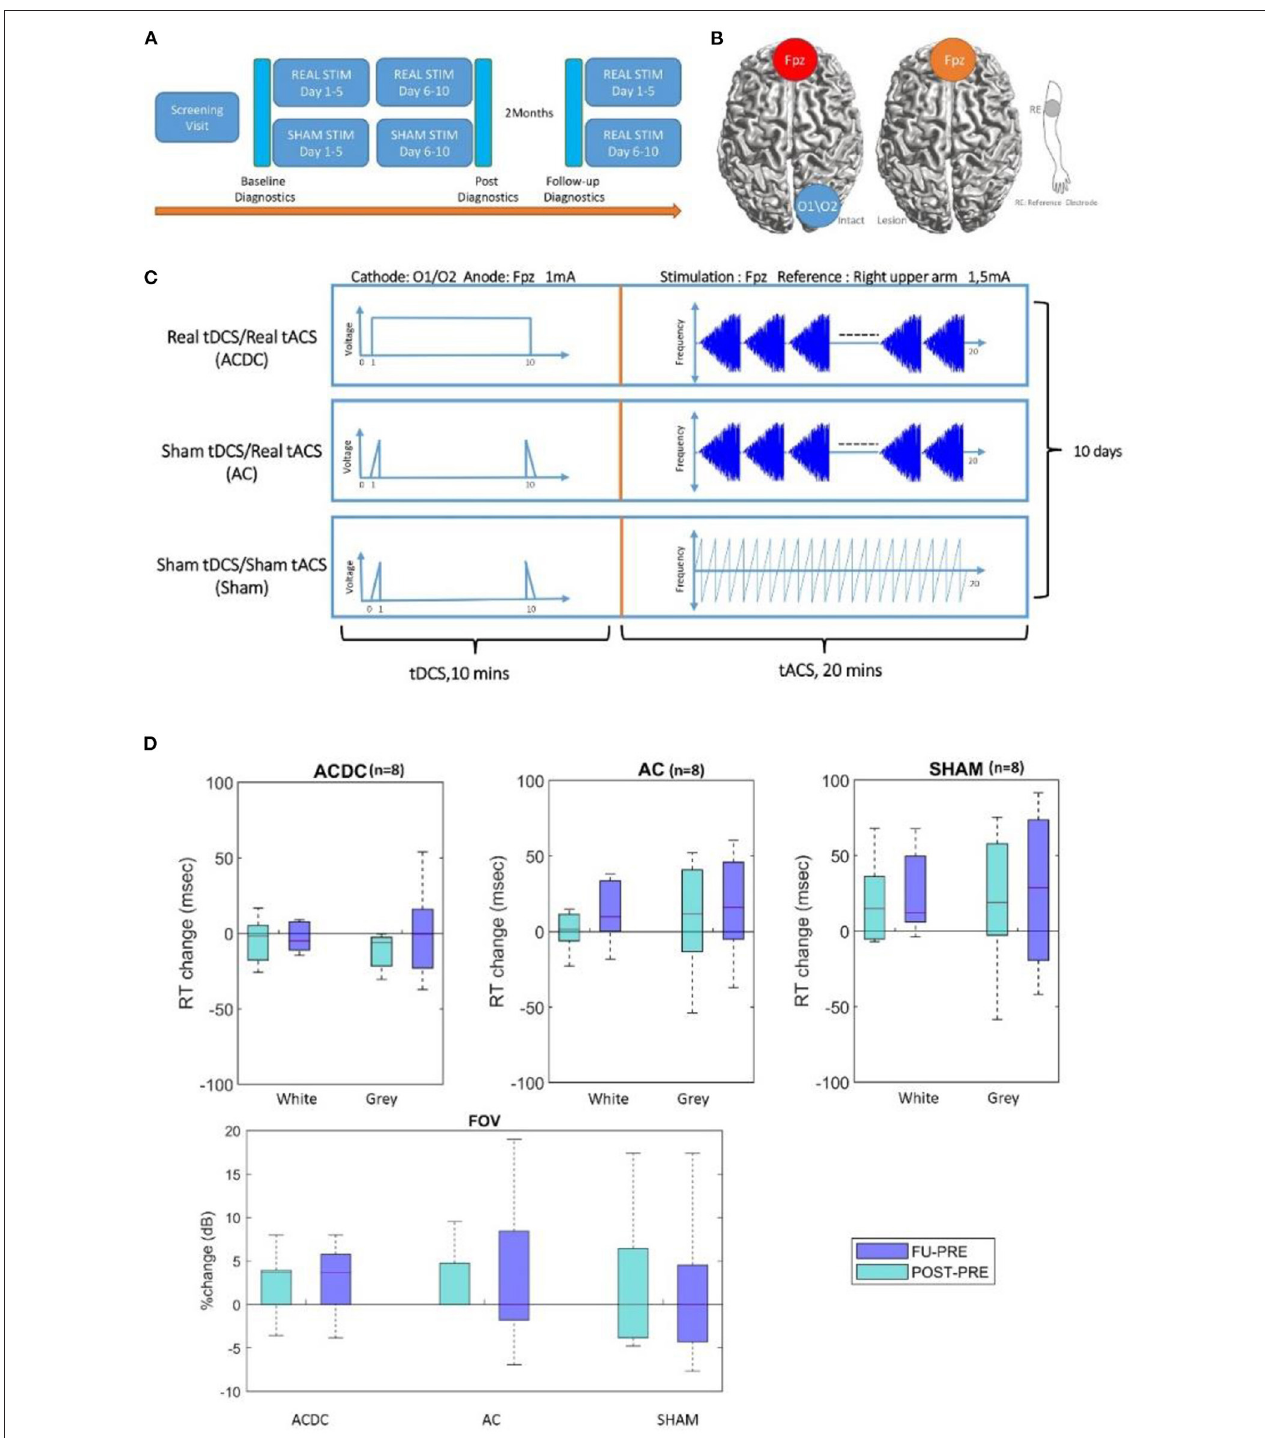
FIGURE 1 | (A) The pipeline for experiment time schedule and postdiagnostic, 5min rsEEG, and visual parameters were recorded before the experiment as a baseline, after 10 days of stimulation, and 2 months later at follow-up. Moreover, all sham patients were offered to receive stimulation treatment after the final evaluation. (B,C) Therefore, three treatment groups were compared: tDCS/tACS (ACDC), sham tDCS/tACS (AC), and sham tDCS/sham tACS (SHAM). (D) Boxplot of White and gray areas’ reaction time in visual field: the percentage change of the reaction time in ACDC decreased while in the two groups it increased. RT, reaction time (unit: millisecond). The bottom part shows the percentage changes in each group, the median of percentage changes of ACDC was positive both in POST and FU. In contrast, AC and SHAM group remains zero. From both high-resolution perimetry and visual field, the ACDC group shows a more promising visual performance improvement than the other two groups. FOV, visual field (unit: